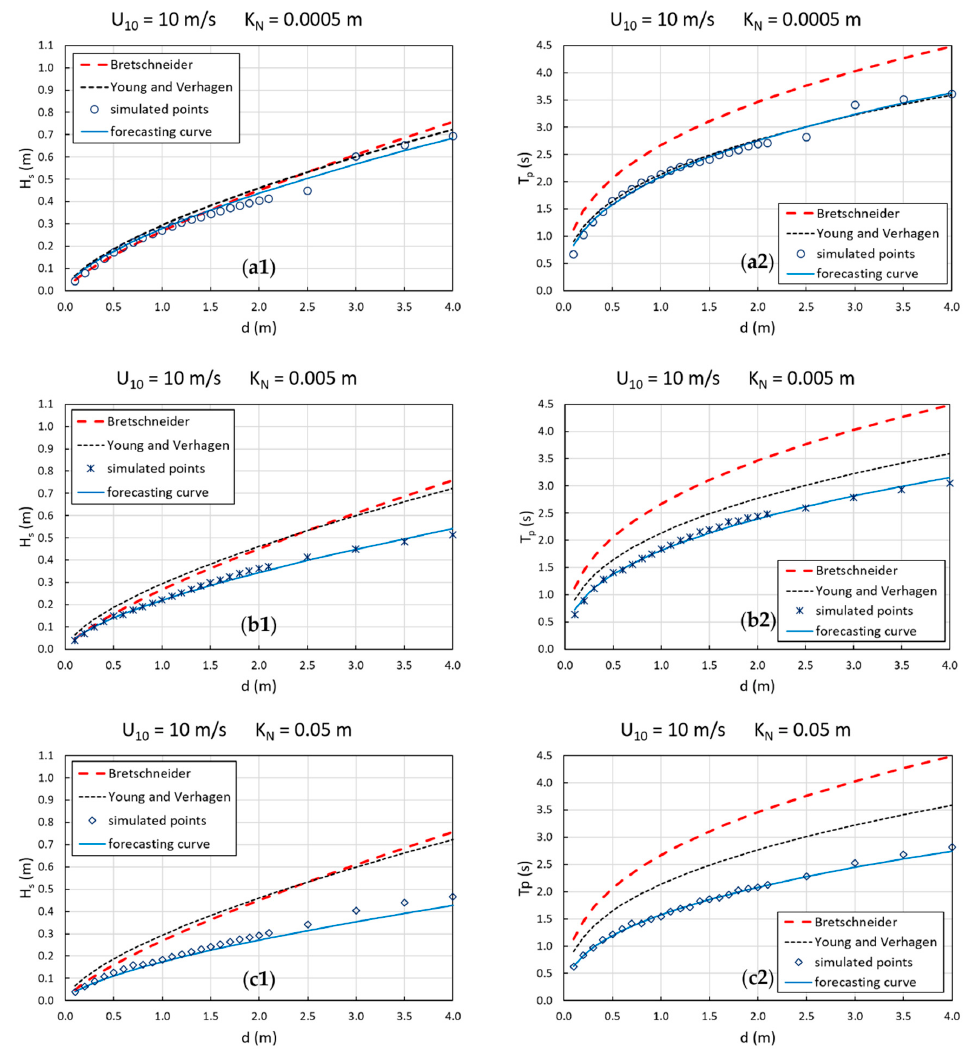
Figure 5. Distribution at varying water depths of the wave field generated by a wind speed U 10 of 10 m/s for different K N values: ( a1 – c1 ) the significant wave height and ( a2 – c2 ) the wave peak period. The red and black dashed lines refer to the growth curves predicted by Bretschneider [58] and Young and Verhagen [26] respectively. The points are the results obtained by means of the spectral model. In particular, the wave height is lowered by 40% compared to the value predicted by assuming a not very dissipative bed. The new forecasting curve of wave energy, having coefficient A and B as reported in Table 2, is almost superimposed on those obtained by Bretschneider [58] and Young and Verhagen [26] when K N is very low, with a maximum percentage difference of 10% and 5% respectively. This confirms the more general validity of the approach. The difference between the curves of Bretschneider [58] and Young and Verhagen [26] is much more important if the peak period